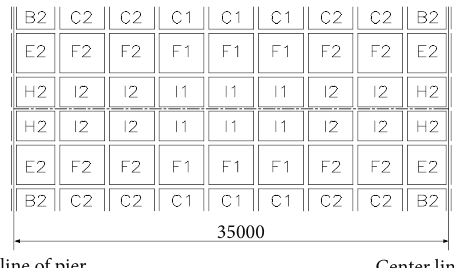
Figure 2: Structural plan of the bridge deck (unit: m).